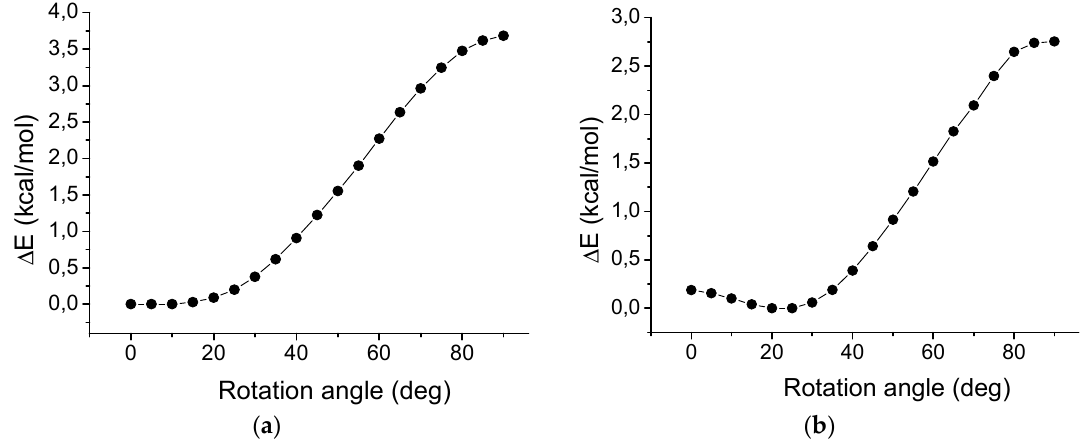
Figure 7. Energy variation upon the rotation of the phenyl group relative to pyrazol-x-yl in phenyl-pyrazol-1-yl ( a ) and phenyl-pyrazol-3-yl ( b ) according to PBE0/def2-TZVP calculation (see Materials and Methods ).